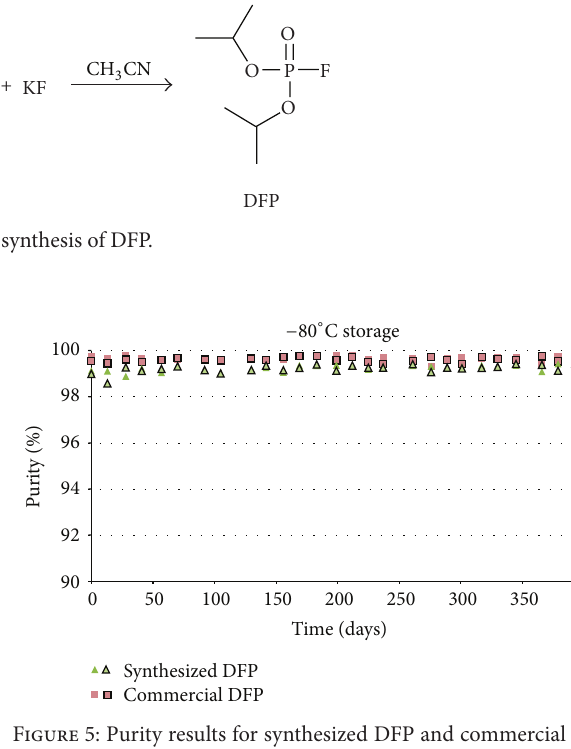
Figure 3: Purity results for synthesized DFP and commercial DFP when stored at 4 ∘ C.